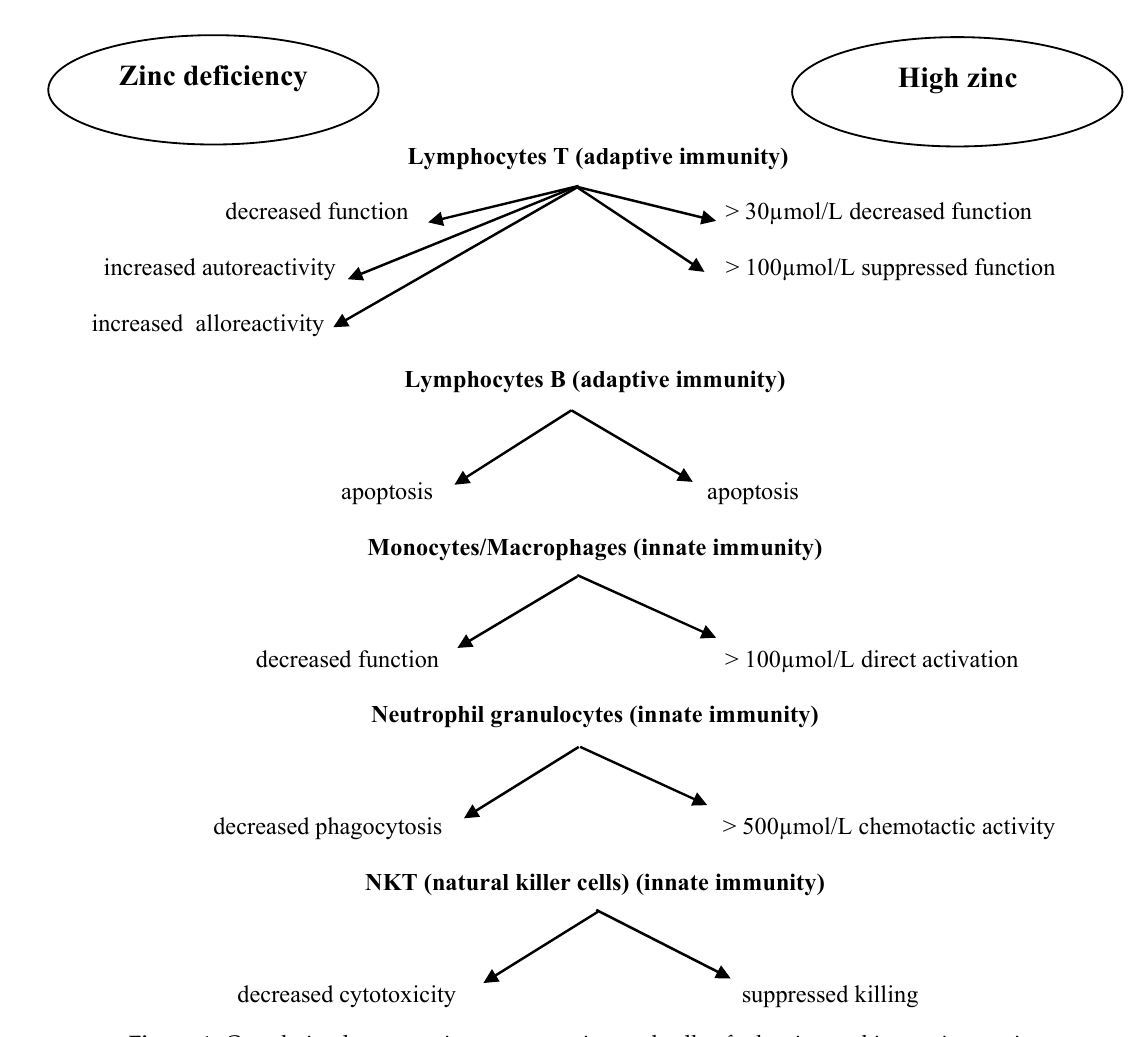
Figure 1. Correlation between zinc concentration and cells of adaptive and innate immunity .